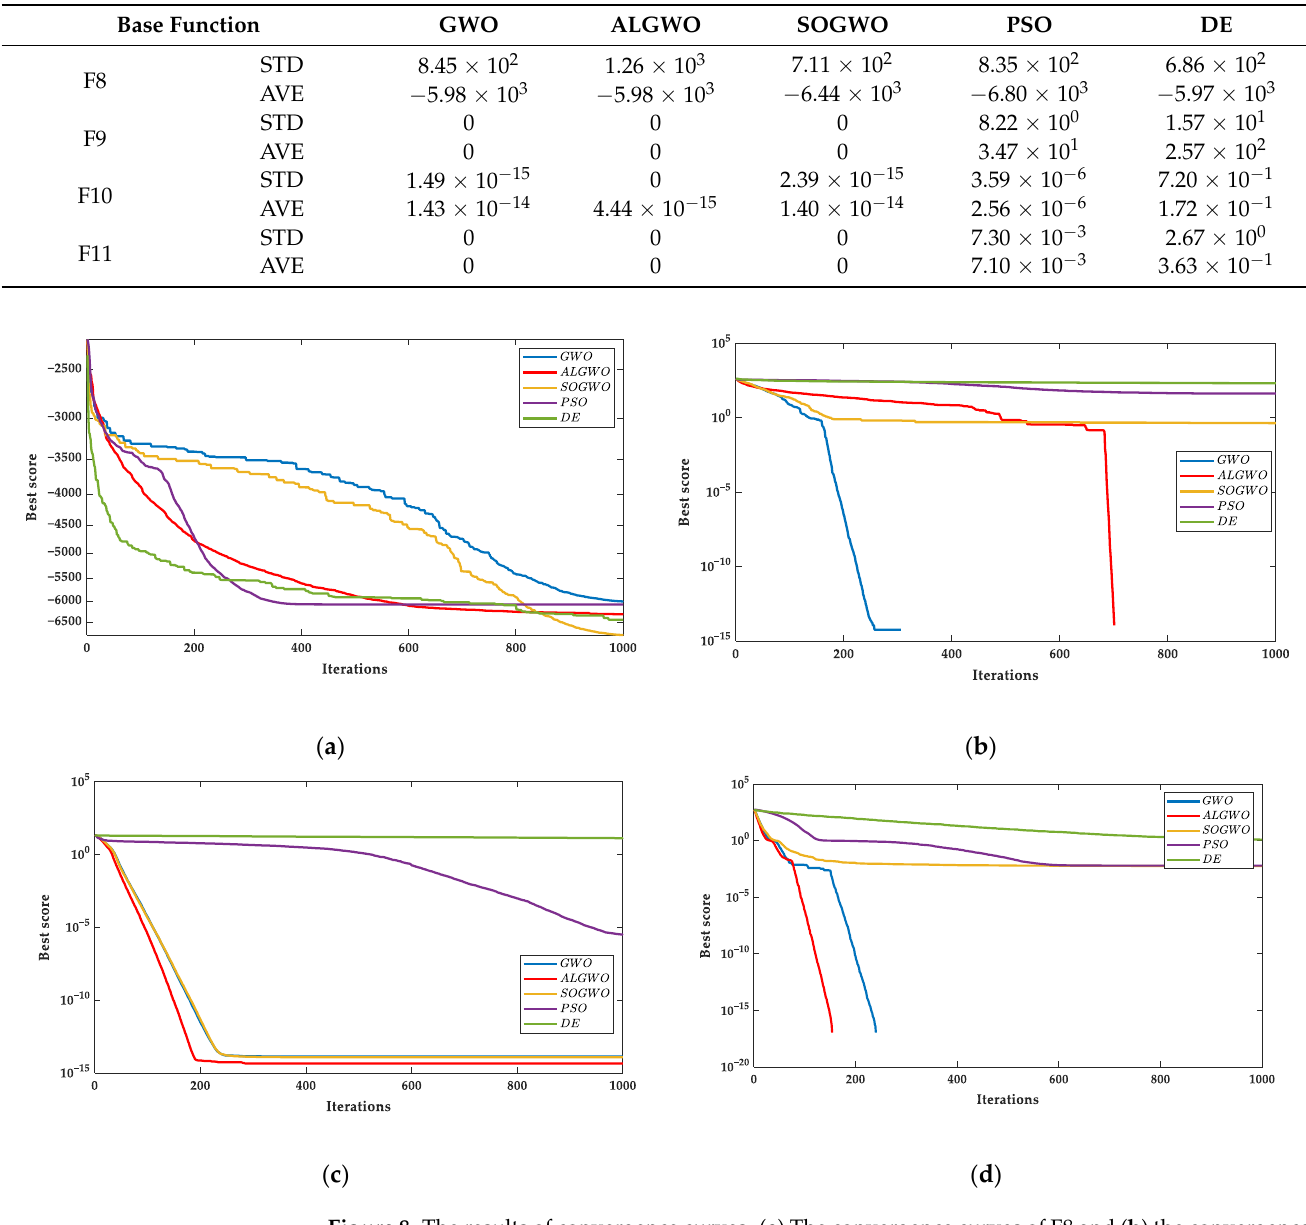
Figure 8. The results of convergence curves. ( a ) The convergence curves of F8 and ( b ) the convergence curves of F9 and ( c ) the convergence curves of F10 and ( d ) the convergence curves of F11. Table 5. Comparison results of five algorithms on four groups of benchmark functions.